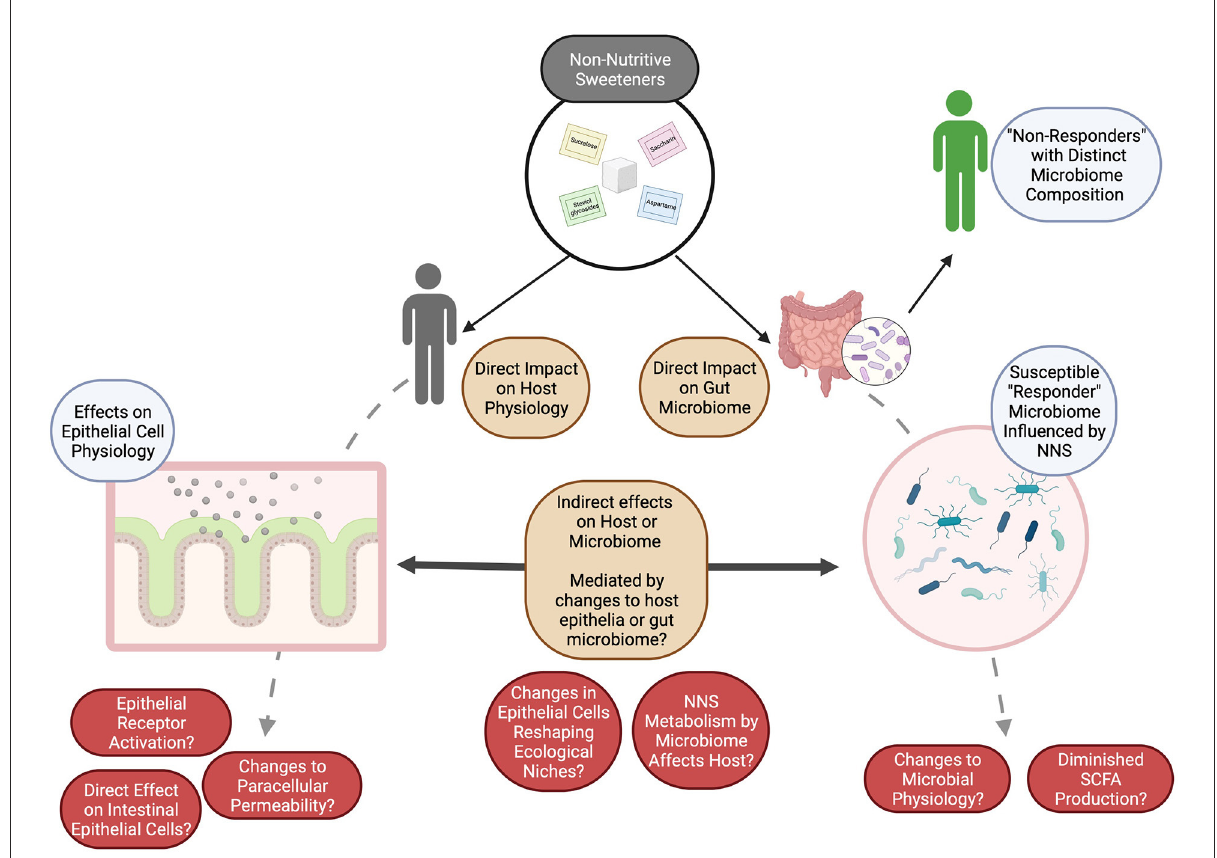
FIGURE1 The potential for NNS to shape both the gut microbiome and host responses to these compounds may be either direct or indirect. Many open questions remain (in red) as to how these impacts or interactions may be measured or monitored, but we speculate (brown) that by investigating the impacts of NNS on (1) the host (especially on morphologically distinct epithelial cells), (2) on the gut microbiome, as a whole, and (3) on the interactions between the gut microbiome and the host, the underlying mechanisms can be described and evaluated for their potential to influence human health. Figure created with BioRender. SCFAs, short chain fatty